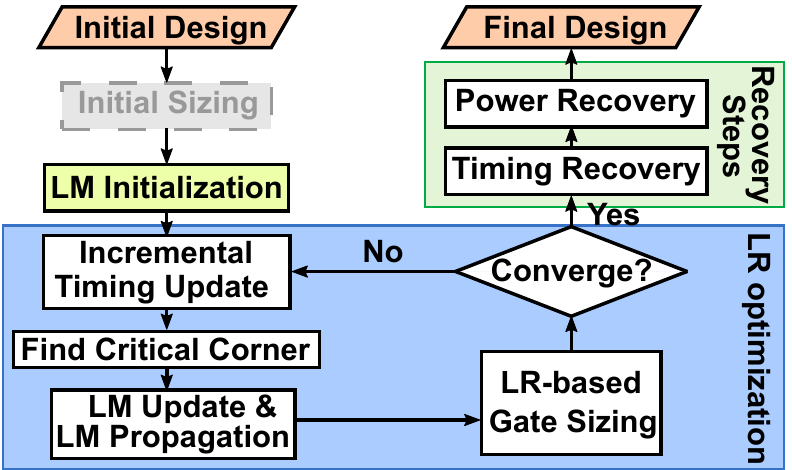
Figure 3. Overall LR-based gate sizing optimization flow. Initially, all gates are downsized to their least leakage power option (lowest size and highest V T ) [36,42] that does not violate any design rule constraint. Solving design-rule violations early, simplifies the following local logic tuning steps. In the following, all LMs are set to a starting value, usually to 1, and the main LR optimization loop starts. Each iteration of LR-based gate sizing begins with a full incremental timing update and then evolves in two phases. In the first phase, the LMs are updated and propagated to all gates to reflect the new criticality of the corresponding timing arcs. In the second phase, for each gate, examined in topological order, all possible discrete cell sizes and threshold voltages are tried, assuming constant LMs. The new version selected for the resized gate is the one that minimizes the cost function (2) and does not introduce any design-rule violations. At each iteration, a full incremental timing update on all examined corners is needed to reflect the new timing violations. From all the available corners, the most critical corner is identified [10] for the current iteration. When there aren’t any timing violations in any corner, we name critical the timing corner that gives the lowest total